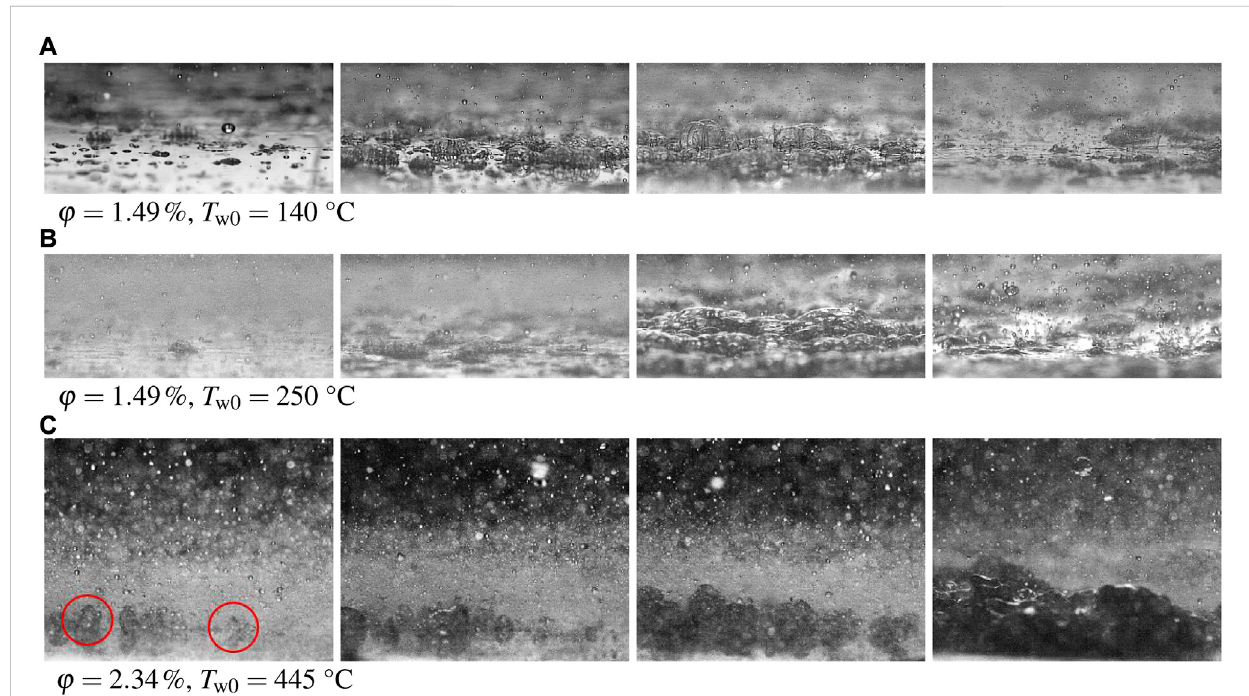
FIGURE 8 Observations of the phenomena accompanied by spray cooling using lubricant solutions φ = 1.49% and φ = 2.34% for different initial wall temperatures. (A) 1.49% solution at 140 ° C wall temperature, (B) 1.49% solution at 250 ° C and (C) 2.34% lubricant at 445 ° C). The development of a foam layer can be clearly seen at all the initial temperatures. The spray parameters are: the mean drop diameter D 10 = 78.7 μ m, the mean impact velocity U = 14.05 m/s and the mass fl ux _ m (cid:1) 2 . 50 ± 0 . 03 kg/m 2 s. The corresponding videos are in the Electronic Supplementary Material [58].